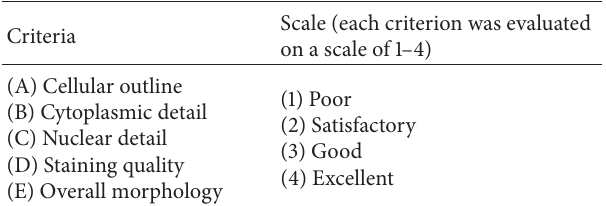
Table 1: Histomorphological